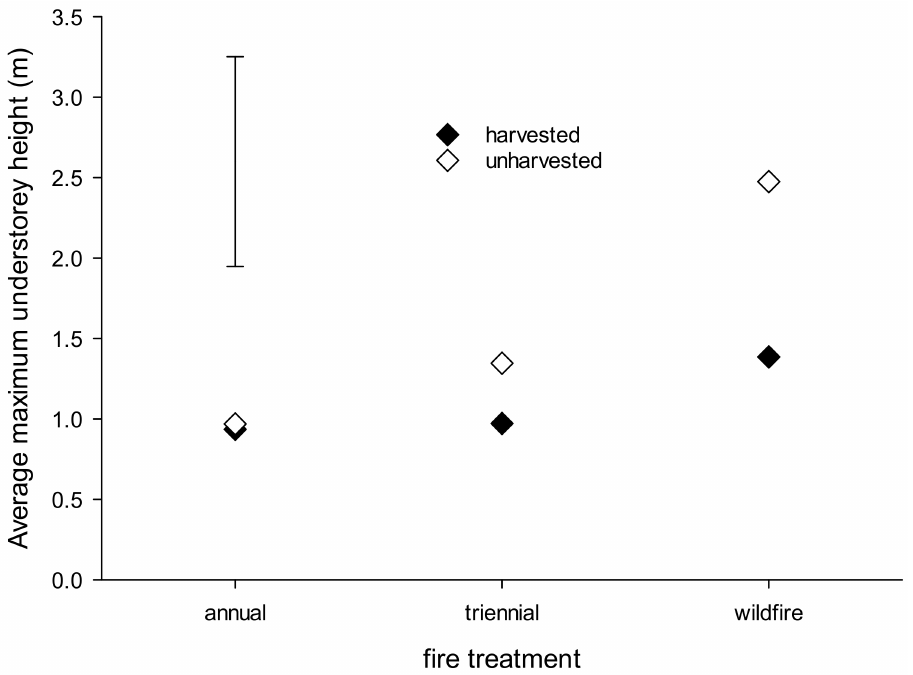
Figure 5. Mean maximum understorey vegetation height for harvested and unharvested transects in each of the three fire treatments. There was a significant fire treatment × harvesting treatment interaction ( p < 0.05). The error bar indicates the LSD based on fire treatment × harvesting treat- ment